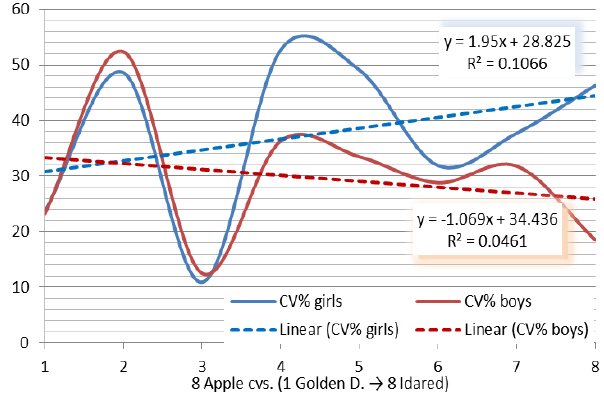
Fig. 10. Coefficient of variation (CV%) for apple taste, evaluated using 1-15 scale (Q1), presented by gender (50% male, 50% female)